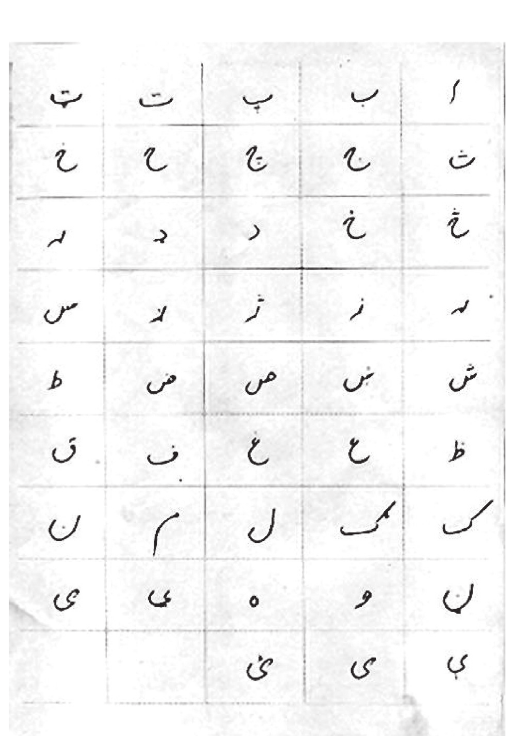
Figure 4: Sample from the data collection.